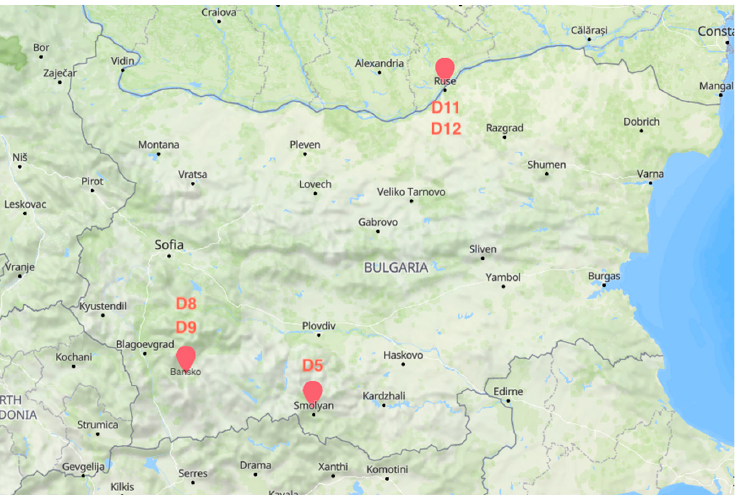
Figure 1. Origin of the sourdough samples—Bulgarian bakery’s locations (D5, Smolyan town, 24.691553, 41.579533; D8, D9, Bansko town, 23.481622, 41.827971; D11, D12, Ruse town,